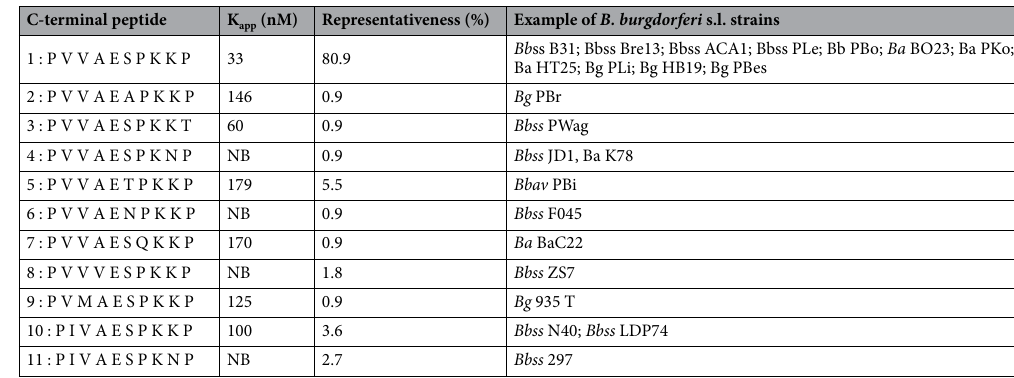
Table 2. Variant of C10 C-terminal peptide. Apparent dissociation constant (K app ) of C10-11 mAb for C10 peptide variants was calculated based on the fitting performed in the competition experiments (Fig. 1). The representativeness of the different sequences of the C10 peptide among Borrelia burgdorferi sl. is given in percentages. NB means no binding. BBss: Borrelia burgdorferi sensu stricto, Ba: Borrelia afzelii, Bg: B. garinii, Bbav: B. bavariensis .